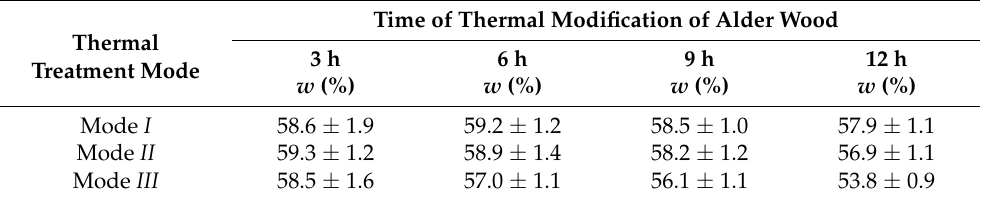
Table 4. Average values of alder wood moisture content in the thermal treatment process. Thermal